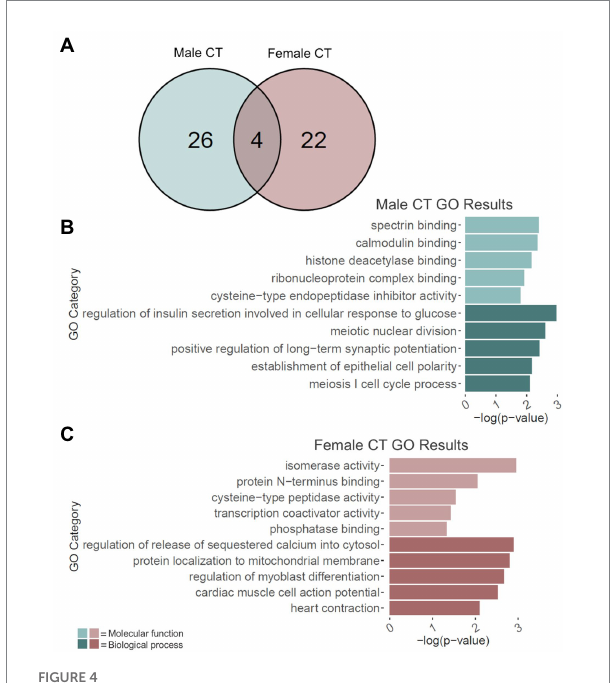
FIGURE 4 GO analysis of cryptically transcribed (CT) genes. (A) Number of genes cryptically transcribed due to adolescent binge ethanol in males and females at p < 0.05. Fisher’s exact test determined male and female gene overlap to be significant, p = 8.2e-09. (B) GO analysis of cryptically transcribed genes with unique to males. (C) GO analysis of cryptically transcribed genes unique to females. Snap25 , Cplx1 , Ccdc124 , and Per1 were cryptically transcribed in both males and females and were excluded from the male and female GO analyses to identify categories unique to each